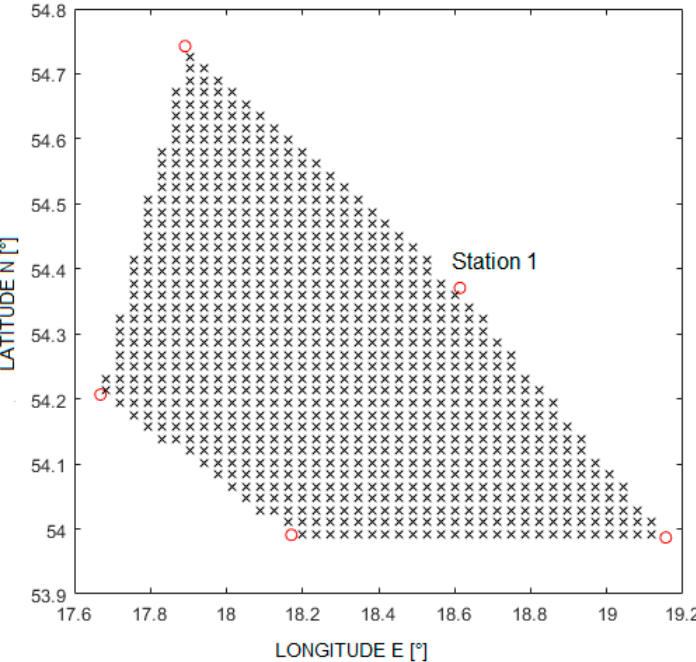
Figure 4. Arrangement of reference stations (‘o’ symbol) and analyzed positions (‘x’ symbol).